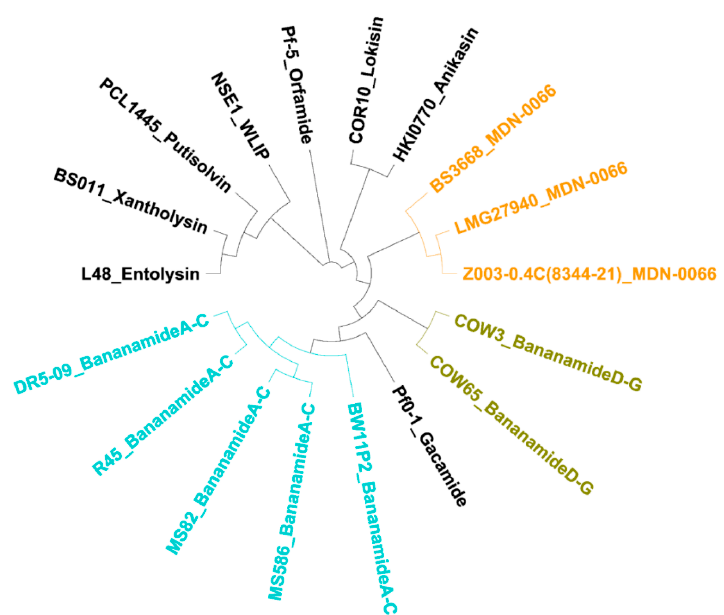
Figure 5. Phylogenetic analysis of concatenated regulatory, export and biosynthetic protein sequences extracted from bananamide D-G, and from other characterized and putative CLP-producing strains. Cladogram of neighbor joining tree inferred from the alignment of concatenated RND e ffl ux system,